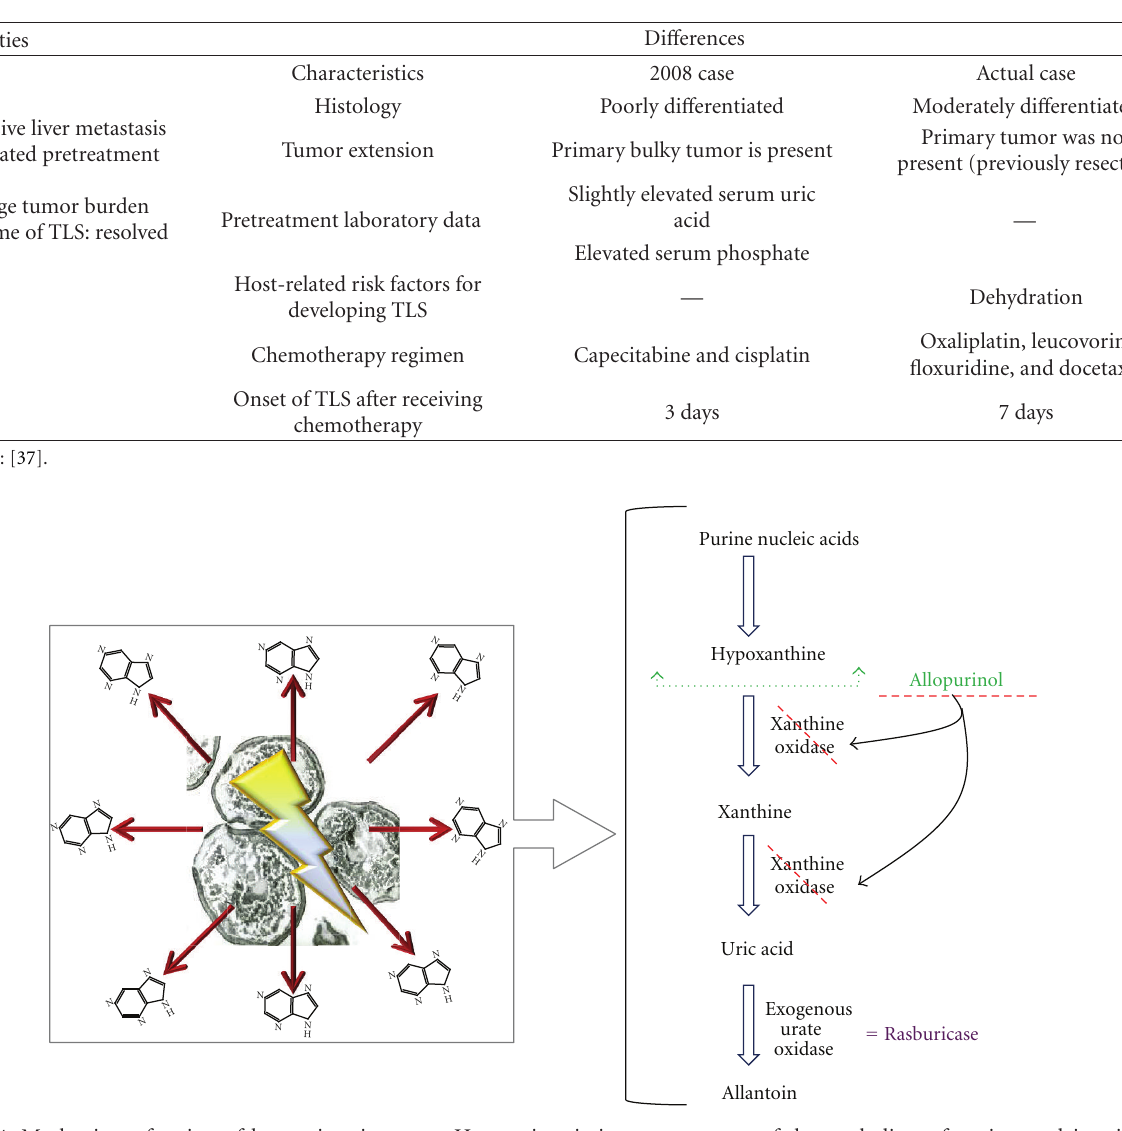
Figure 4: Mechanism of action of hypouricemic agents. Hyperuricemia is a consequence of the catabolism of purine nucleic acids to hypoxanthine and xanthine and then to uric acid via the enzyme xanthine oxidase. Allopurinol is a competitive inhibitor of the enzyme xanthine oxydase. Rasburicase (exogenous urate oxidase) leads uric acid to a more soluble compound,